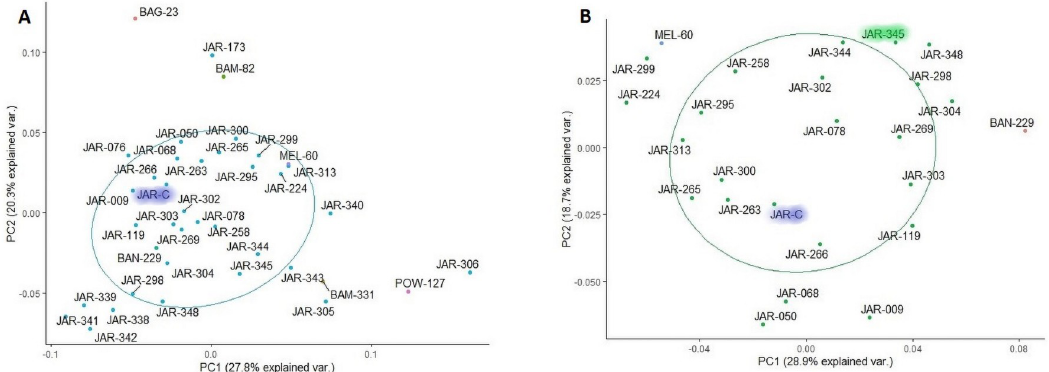
Fig 6. Cluster analysis with new Jarrah samples (JAR-A, JAR-B, JAR-C); preliminary JAR core cluster (a) and refined JAR core cluster